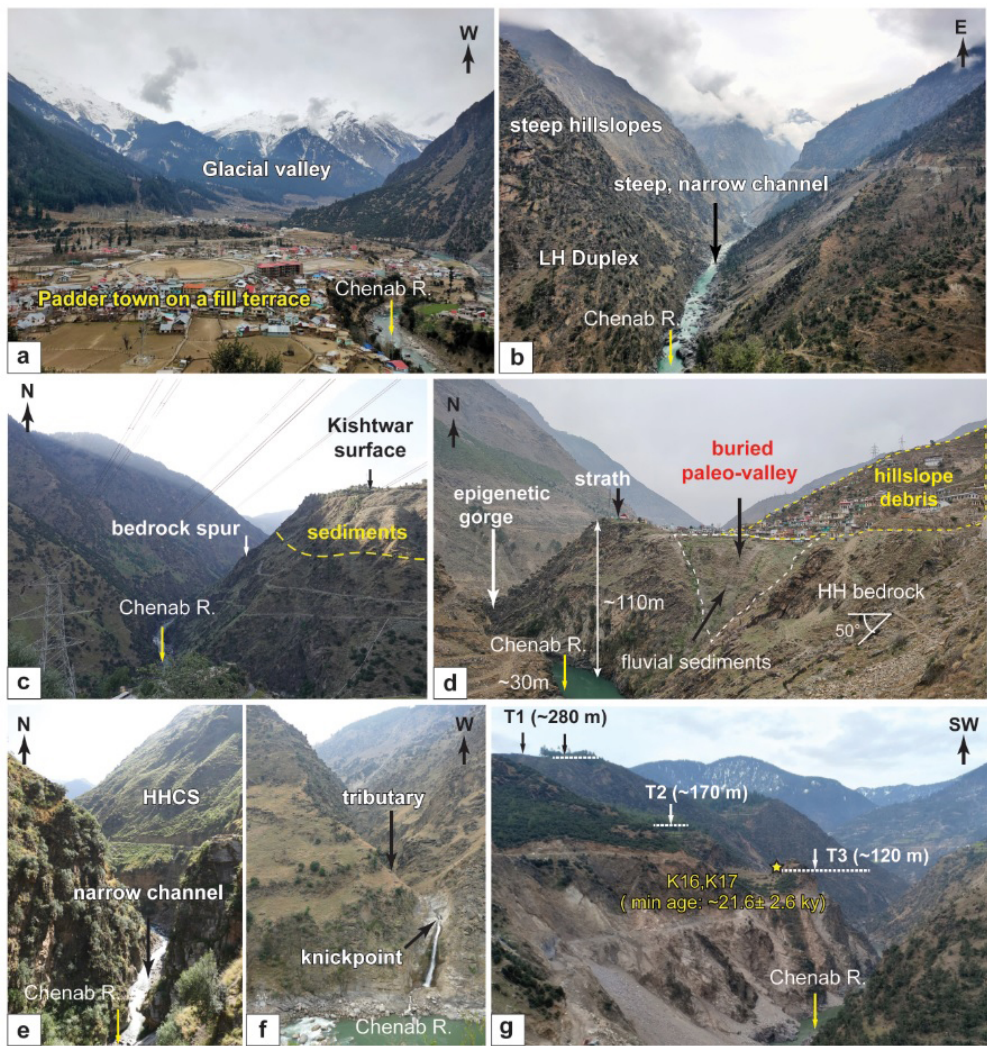
Figure 3. Geomorphic features observed along the Chenab River across the KW. (a) Where the Chenab River enters the KW, the major tributaries coming from the Zanskar Range in the north are characterized by a “U-shaped” valley, suggesting repeated glacial occupancy during the Quaternary. The Chenab valley is unusually wide here, providing space for transient storage of glacial outwash sediments. The present-day river re-incises these sedimentary fills. The photograph was taken near the town of Padder (see Fig. 1a). (b) At the core of the KW, the Chenab valley is V-shaped. The Chenab River is steep and maintains a narrow channel width. (c) Highly elevated fluvial strath surfaces are preserved in the vicinity of the town of Kishtwar, and fluvial incision is observed along the N–S traverse of the Chenab River. The photograph was taken from the south of Kishtwar. The Kishtwar surface ( ∼ 400m high from the river) is underlain by ∼ 150–170m thick sediment cover overlying the tilted Higher Himalayan bedrock. The river has incised another ∼ 240m of bedrock in this section. (d) Epigenetic gorge formed along the Chenab River in its N–S traverse through the HHCS. The town of Drabshalla is built on the hillslope deposits. (e) The Chenab River has maintained a very narrow channel (width: ∼ 20–25m) through moderately strong HHCS rocks, suggesting a tectonic imprint on topography. (f) Formation of a knickpoint at the confluence of the tributary with the trunk stream, implying rapid fluvial incision of the trunk stream. (g) Three levels of strath surfaces observed below the Kishtwar surface. The strath levels are marked as T1 ( ∼ 280m), T2 ( ∼ 170m) and T3 ( ∼ 120m). OSL dating of fluvial sediments lying above the T3 surface yield a minimum depositional age of ∼ 21 . 6 ± 2 .